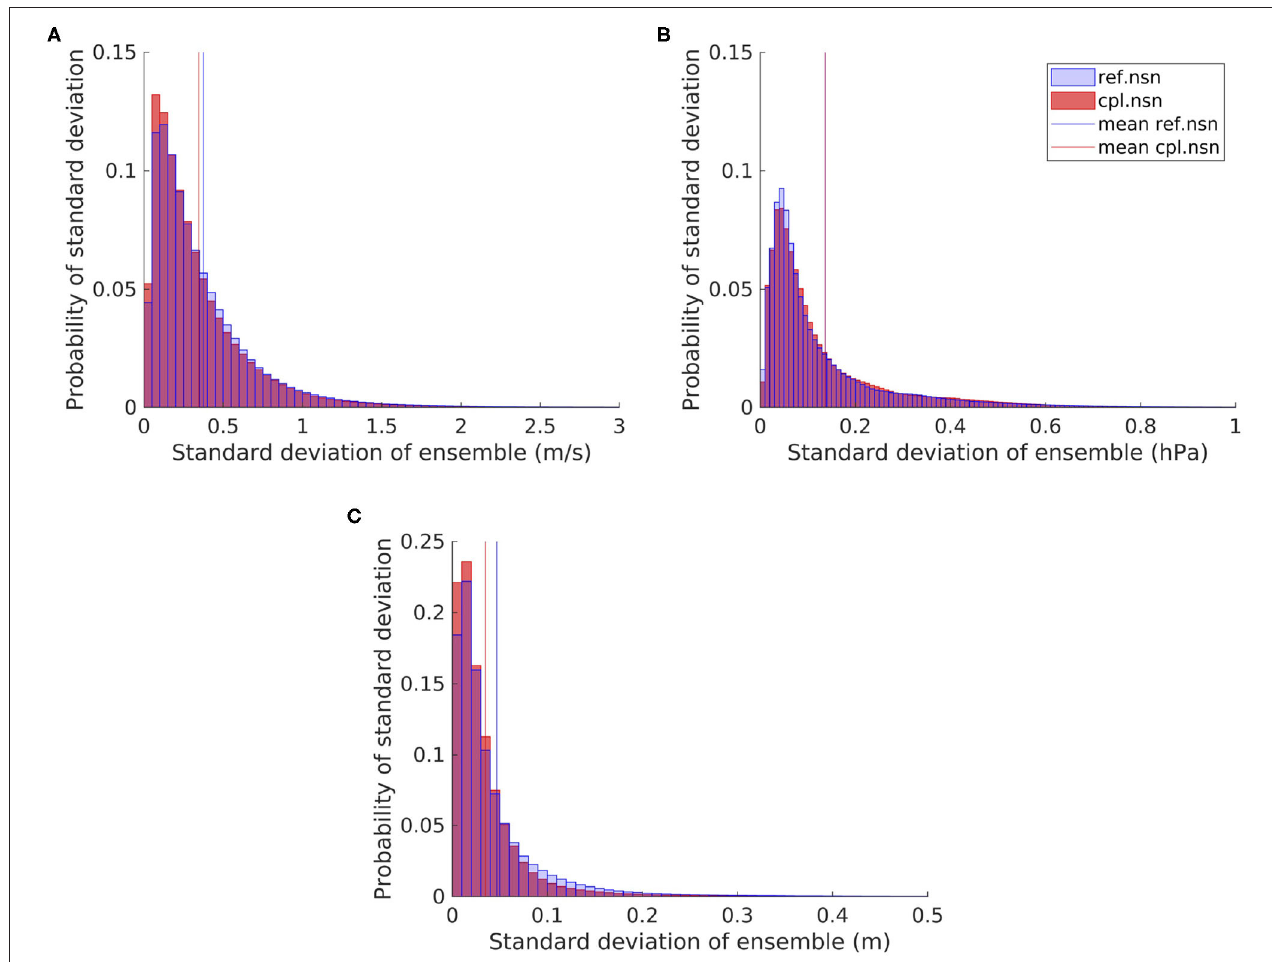
FIGURE 6 | Histogram of the standard deviation of the reference (ref.nsn) and coupled (cpl.nsn) ensembles within the North Sea for the wind speed (A) , MSLP (B) , and significant wave height (C) .